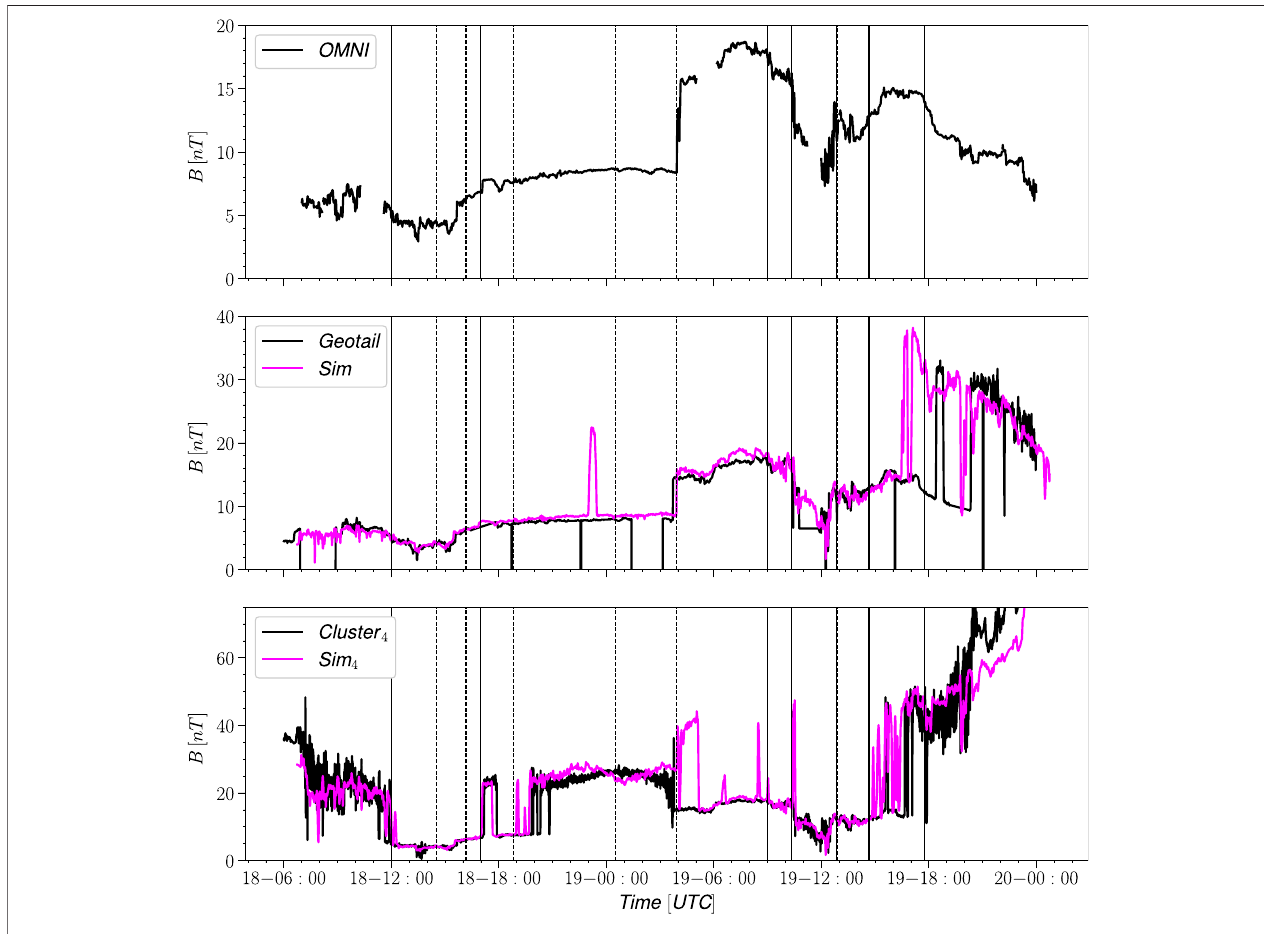
FIGURE 3 | Magnetic fi eld magnitude trace observation (black) vs simulation (magenta) Geotail and Cluster 4.